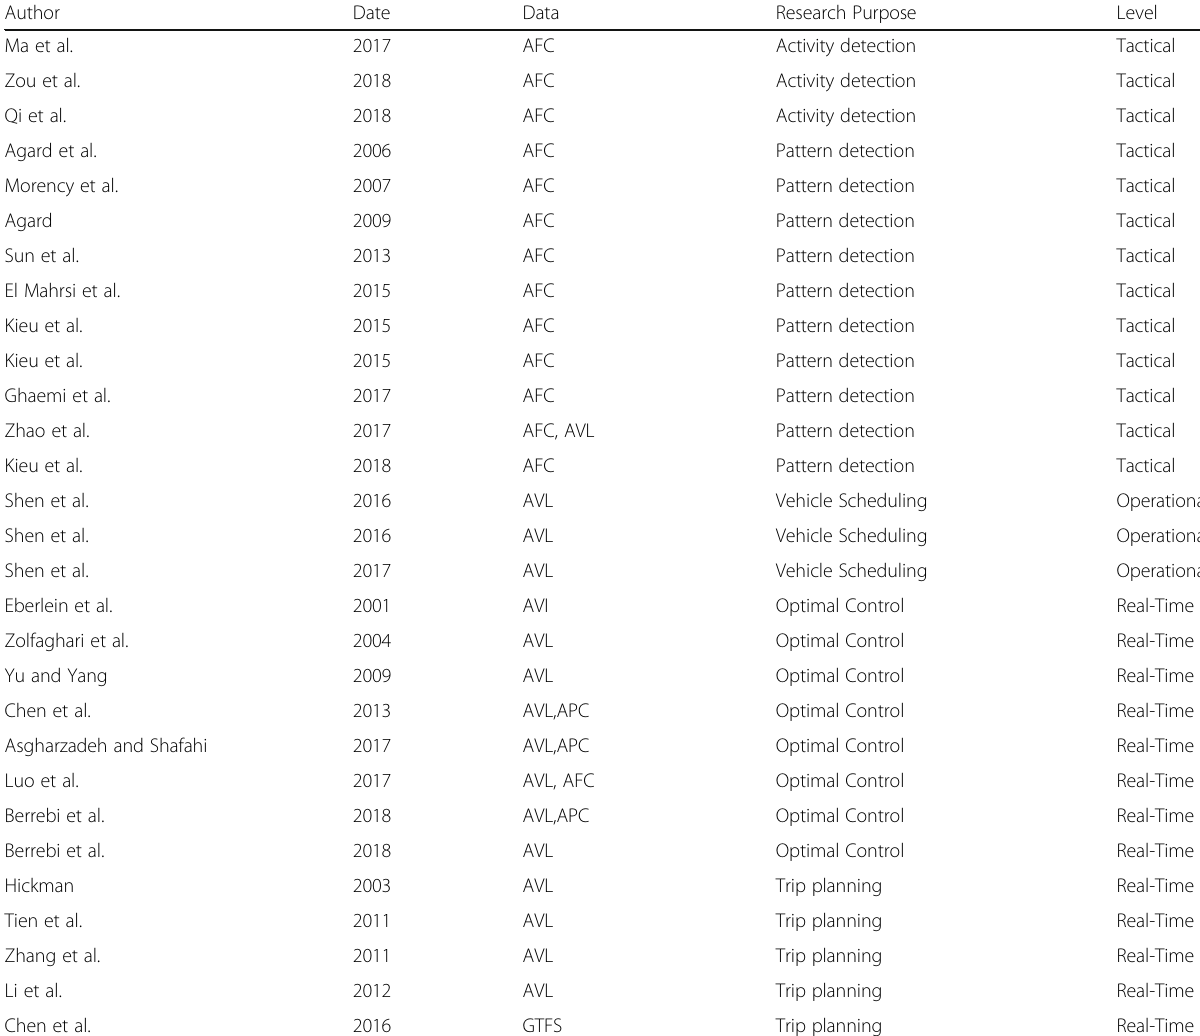
Table 1 Overview of studies using ITS data by research purpose and planning level